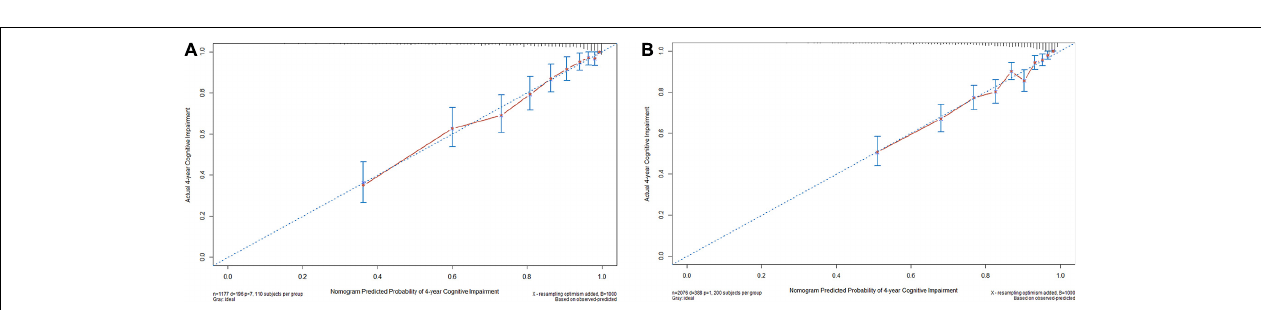
FIGURE 2 | Nomogram for predicting the 4-year cognitive impairment probability. To calculate the cognitive impairment probability for a specific patient, locate patient’s MCR status, and draw a line straight upward to the Points axis to determine the score associated with that status. Repeat the process for age, education status, baseline cognition, and gender; sum the scores for each factor; and locate this sum on the Total Points axis. Then, draw a line straight down to the corresponding 2- or 4-year cognitive impairment probability axis to find the predicted cognitive impairment probability.